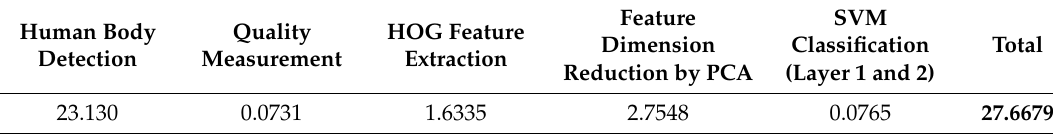
Table 14. The processing time of our proposed method (unit: